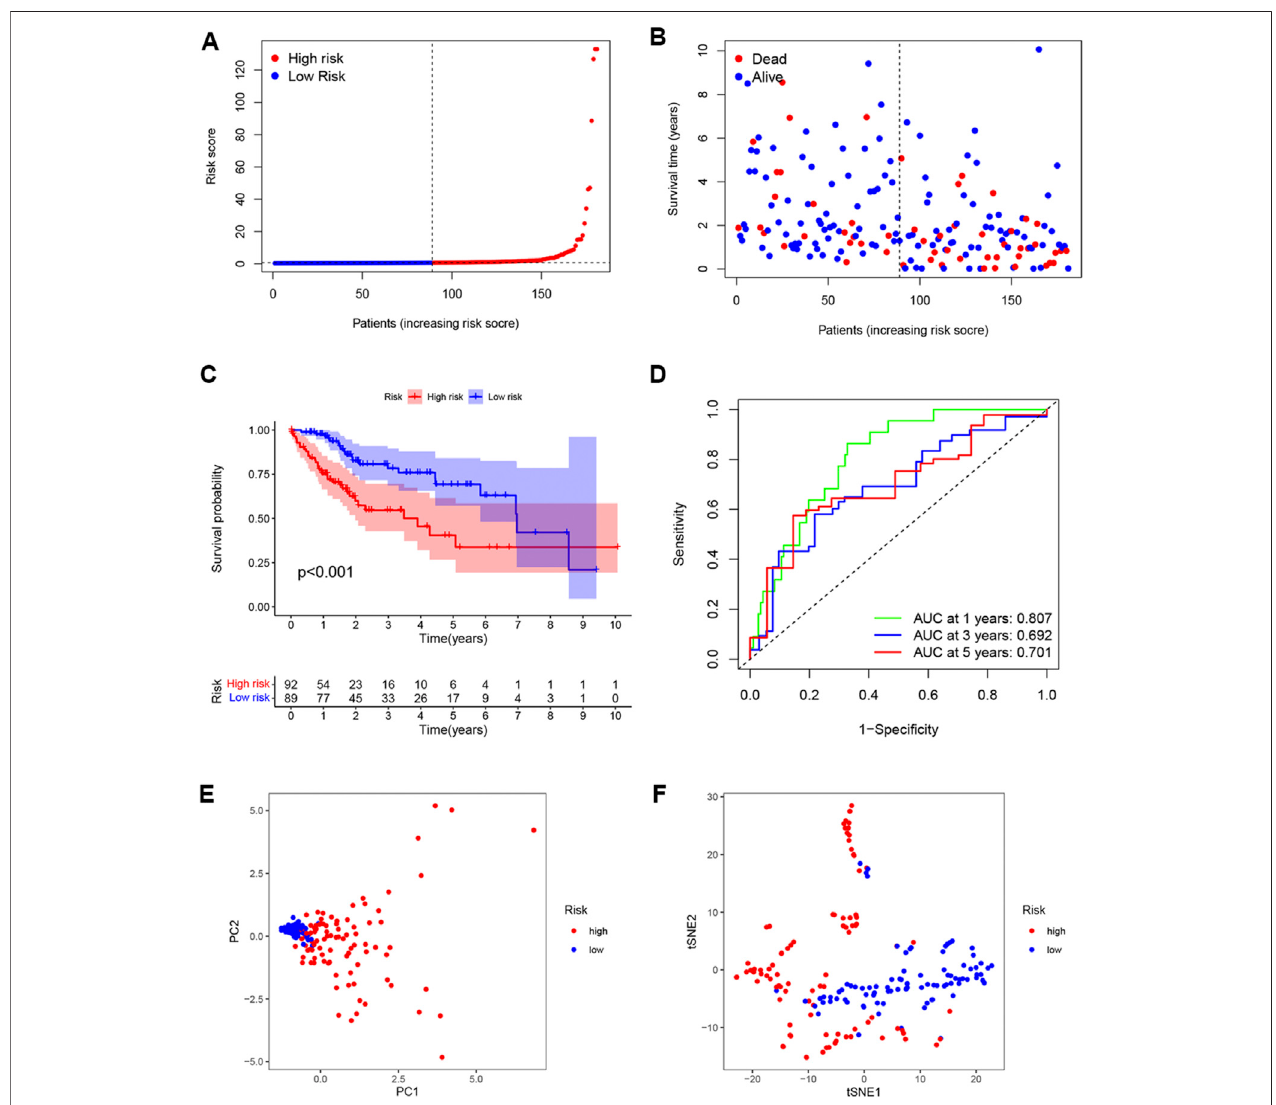
FIGURE 5 | External validation of OS signature. (A) Distribution of validation set risk scores. (B) OS status in the LIHC validation set. (C) K-M analysis of OS in the two groups. (D) AUCs of ROC curves in the validation set. (E) PCA plot showing the signi fi cant difference between the two groups in the validation set. (F) t-SNE uses dimensionality reduction to show the difference between the two groups in the validation